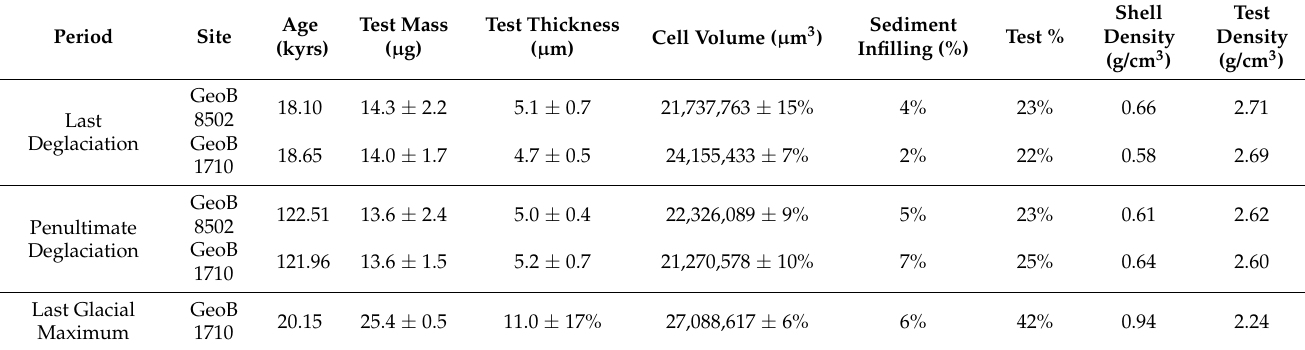
Table 3. Biometric data of foraminifera from weighing and X µ CT analysis. Test thickness is the ratio of calcite volume to calcite surface, and shell and test density are the ratio of the average shell weight to test and shell volume, respectively. Sediment infilling is the specimen’s internal volume percentage occupied by sediment impurities. The µ CT analysis results for individual specimens are given in Supplementary Table S2.